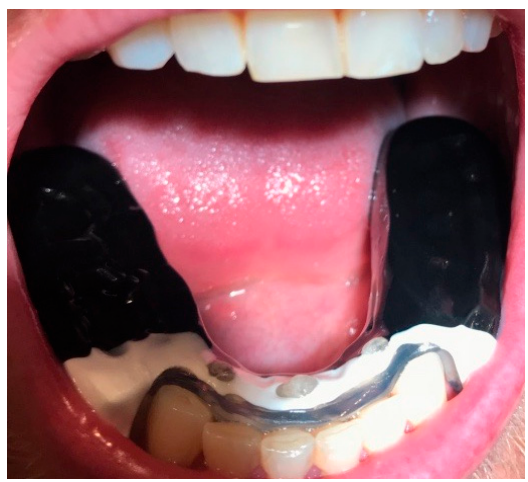
Figure 8. Ergometer for kayak simulation.